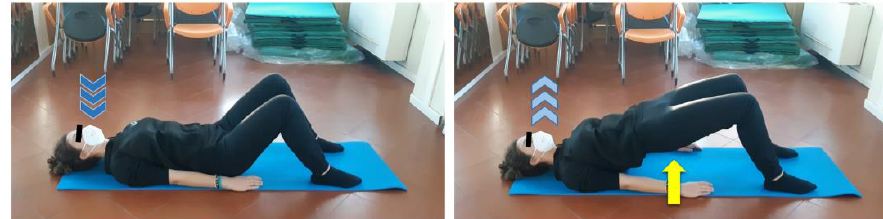
Figure 3. Glutes strengthening and hip mobility exercise. Supine position, flex both legs, set feet hip-width apart close to glutes, arms laying by body sides with hand palms down. Inhale (dark blue arrows), exhale (light blue arrows) while lifting glutes from the floor performing a bridge (yellow arrow) until reaching a complete hip extension. Keep this position for a few seconds, then slowly get back to the starting position. Focus on core stability, unload body weight on feet, arms and shoulders and keep lumbar spine in neutral position while performing the bridge. Three sets of one minute and a half each, 30 s of recovery.